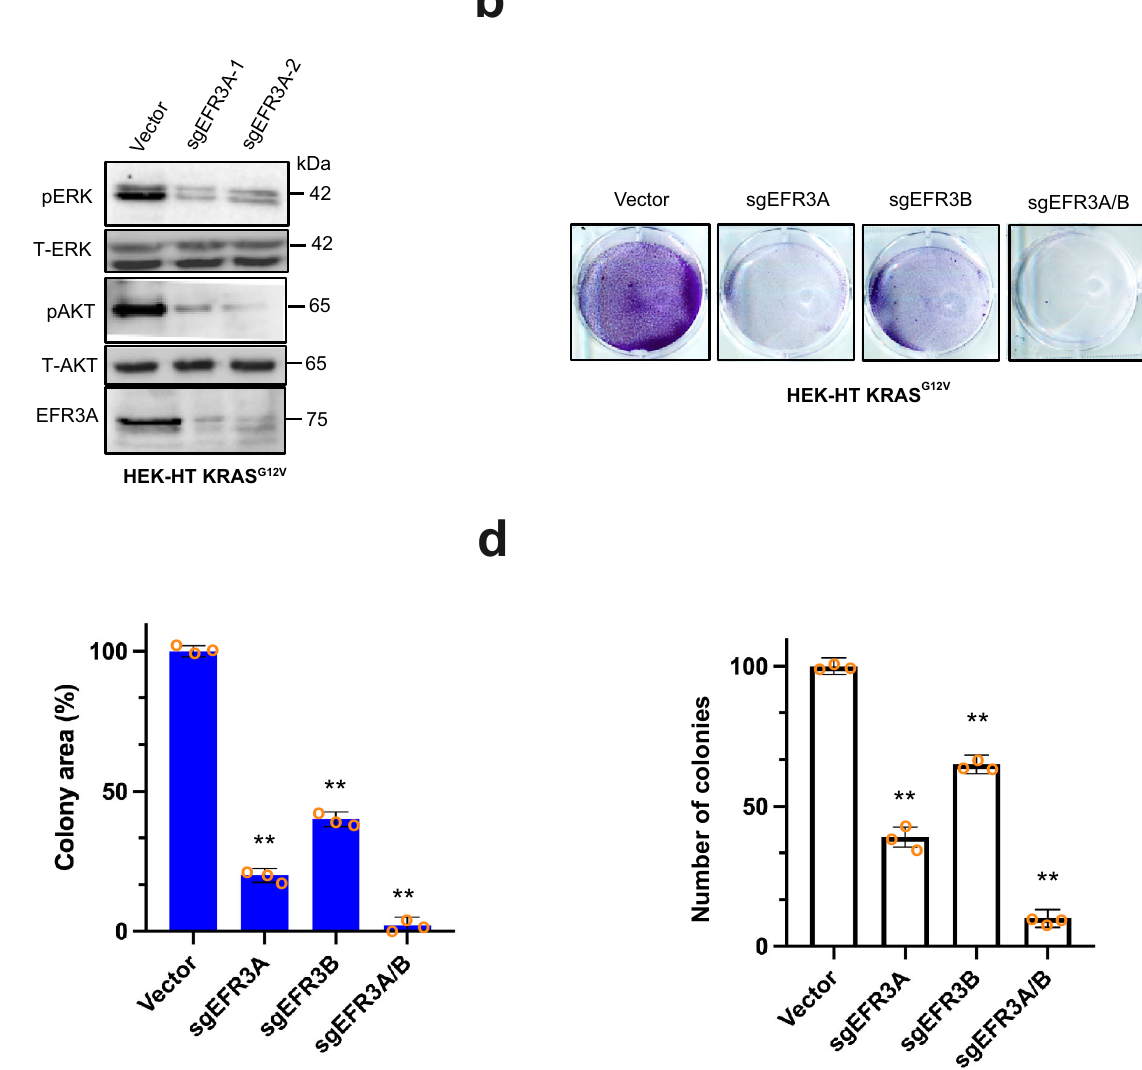
Fig. 2 EFR3A loss inhibits oncogenic RAS signaling and transformed growth in isogenic cells. a – d Analysis of the ( a ) levels of phosphorylated (P) and/or total (T) ERK, AKT, EFR3A, and actin (as a loading control), as assessed by immunoblot, b an example of colony formation, as assessed by crystal violet staining, which is ( c ) plotted as the mean ± SD total colony area, and ( d ) the mean ± SD number of colonies growing in soft agar of human HEK-HT cells transformed by oncogenic KRAS G12V (codon-optimized in d ) engineered to stably express Cas9 and a vector encoding no sgRNA (vector) or the indicated sgRNAs. Representative of 3 biological replicates tested in 3 independent experiments. Replicate experiments and full-length gels are provided in Supplementary Fig. 11. Signi fi cance values calculated by one-way ANOVA test for ( c , d ): ** p < 0.01. Speci fi c p values for ( c ) are 0.0078 ( sgEFR3A ), 0.0045 ( sgEFR3B ), and 0.0016 ( sgEFR3A/B ), and ( d ) are 0.0059 ( sgEFR3A ), 0.0083 ( sgEFR3B ), and 0.0026 ( sgEFR3A/B